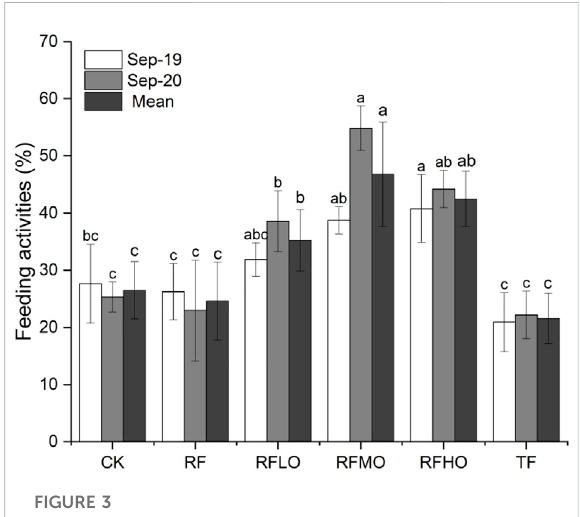
FIGURE 2 Principal component analysis (PCA) for soil chemical characteristics (2019, 2020) is formed by the fi rst principal component (PC1) and the second principal component (PC2) according to fertilization management practices. * Ca, exchangeable Ca concentration (mg · kg − 1 ); Mg, exchangeable Mg concentration (mg · kg − 1 ); TK, total K concentration (g · kg − 1 ); CEC, cation exchange capacity (cmol · kg − 1 ); AN, available nitrogen (mg · kg − 1 ); TP, total P concentration (g · kg − 1 ); K, exchangeable K concentration (mg · kg − 1 ); TN, total N concentration (g · kg − 1 ); TOC, organic C concentration (g · kg − 1 ); TC, total C concentration (g · kg − 1 ); Na, exchangeable Na concentration (mg · kg − 1 ); AP,